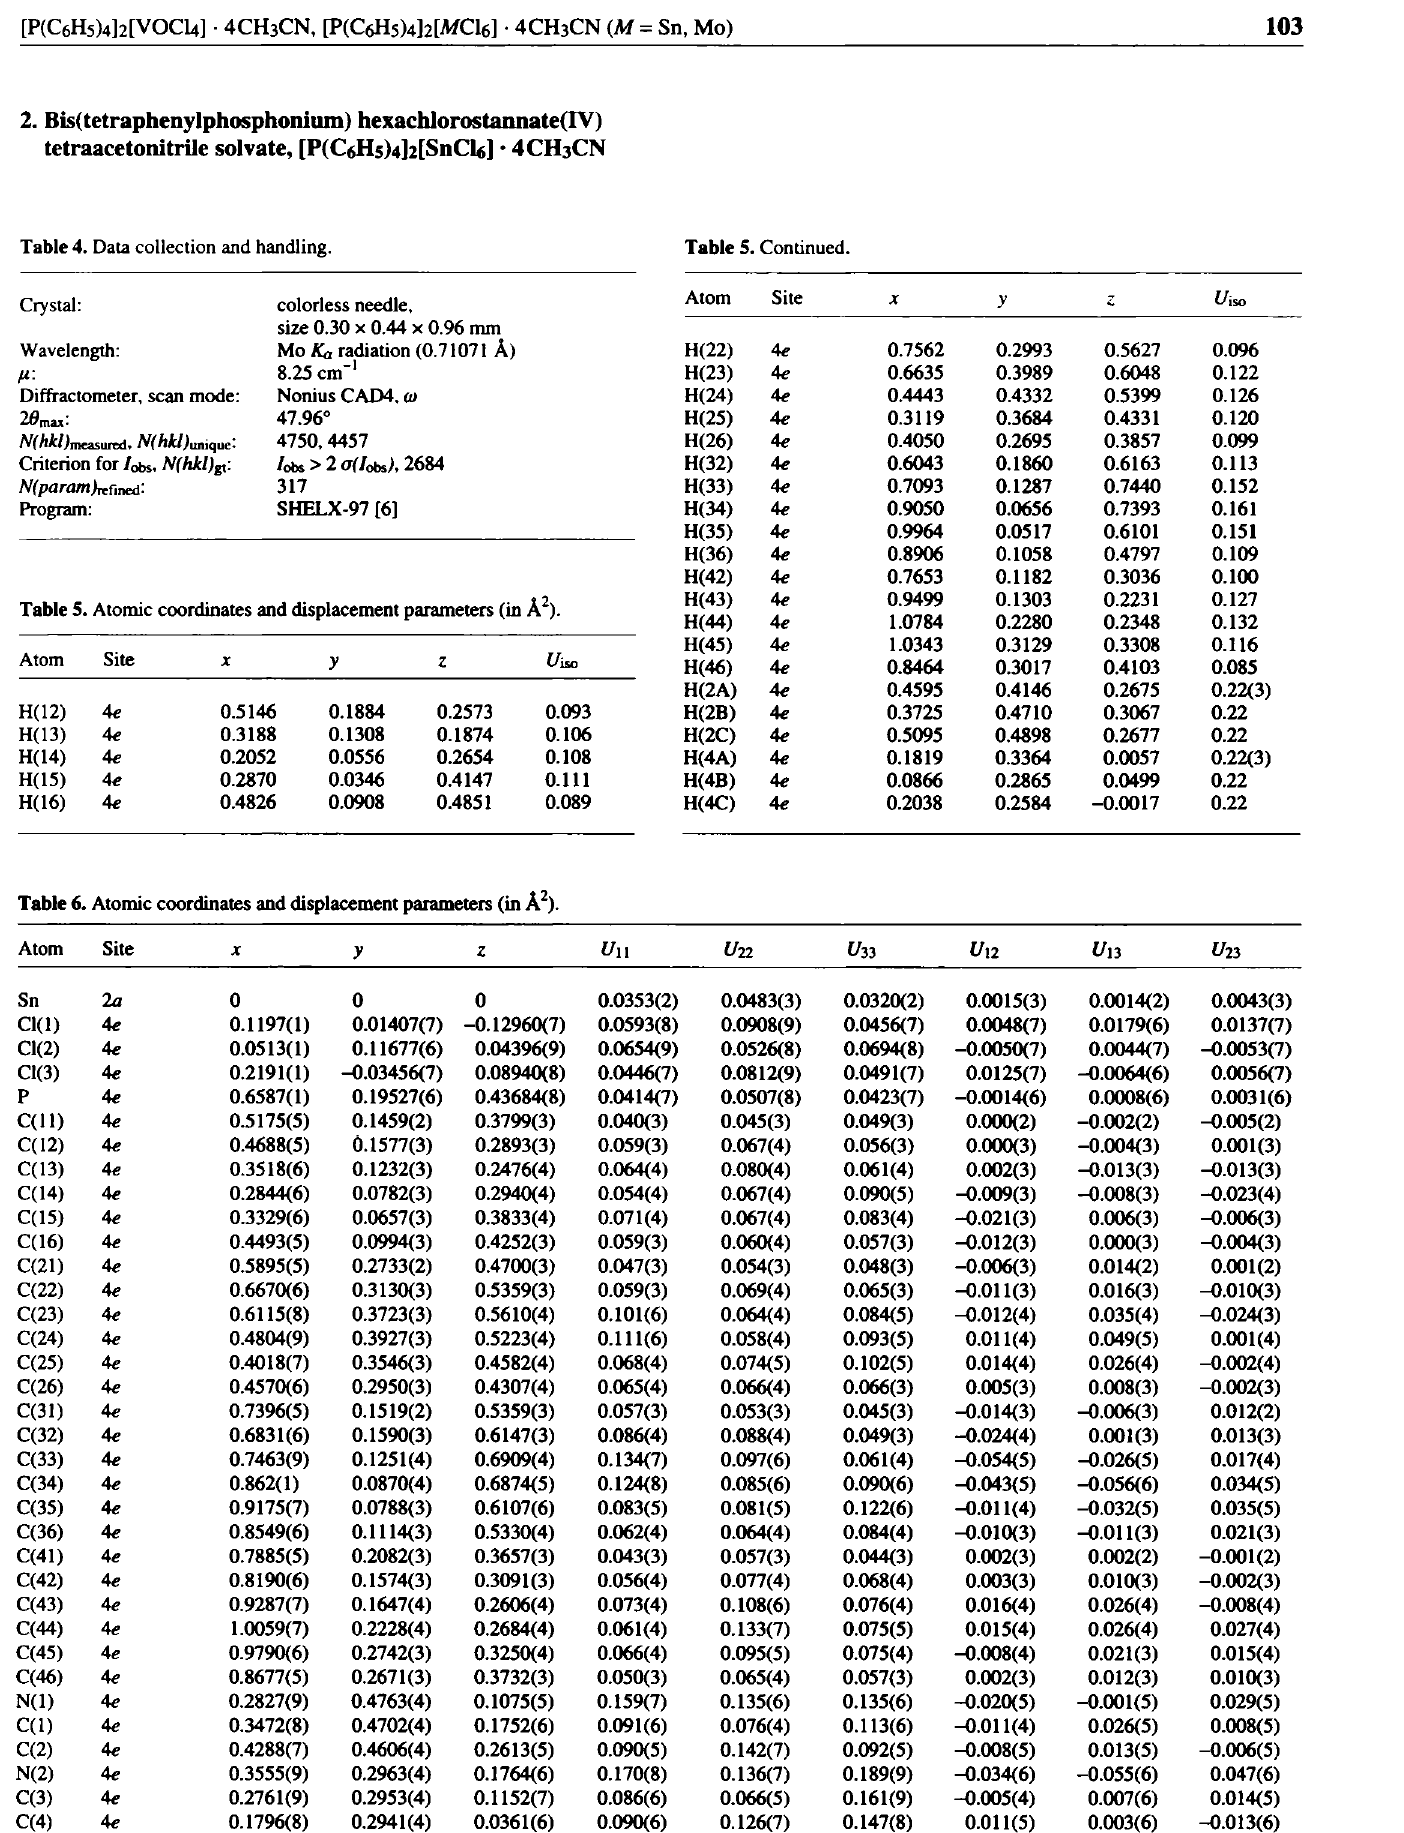
Table 4. Data collection and handling.